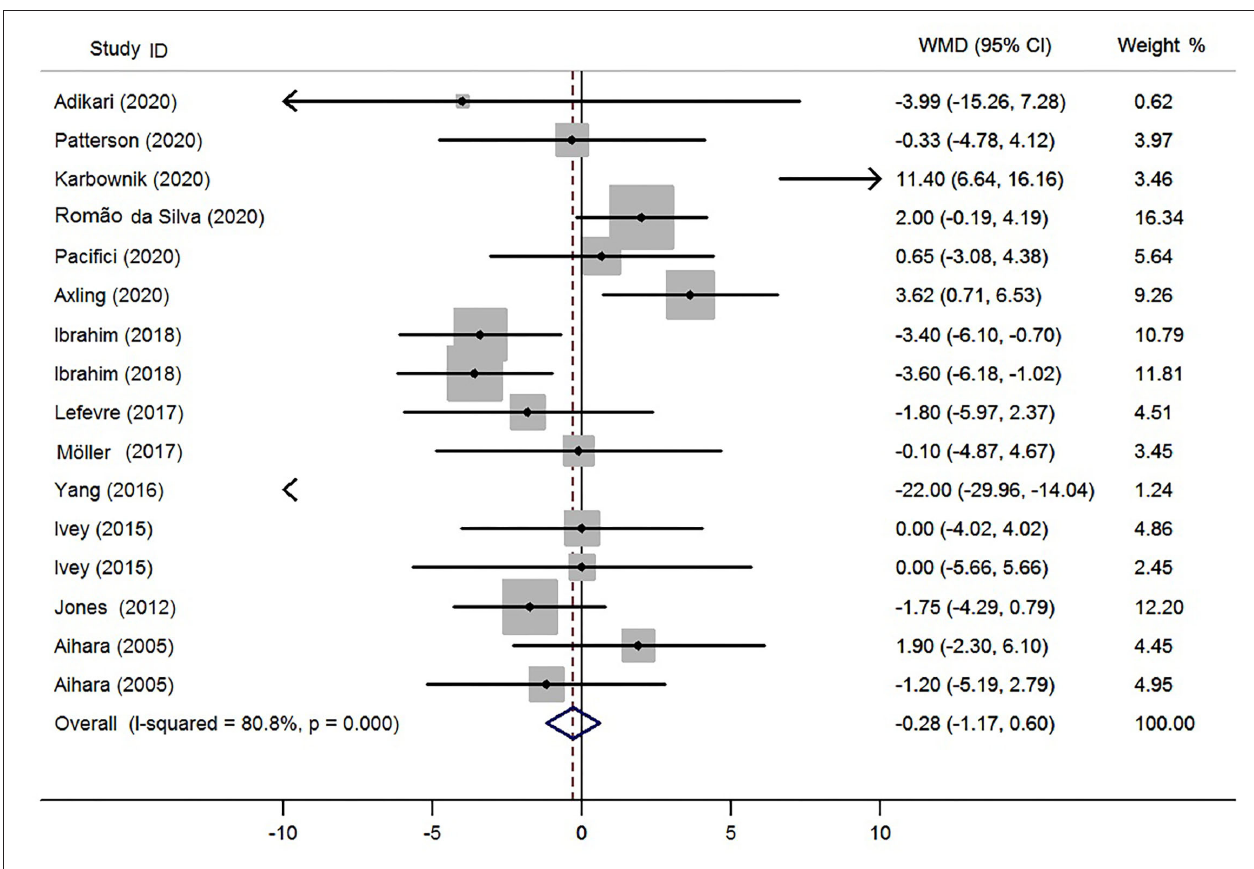
FIGURE 2 | Meta-analysis of the effects of probiotics supplementation on heart rate (bpm). WMD, weighted mean